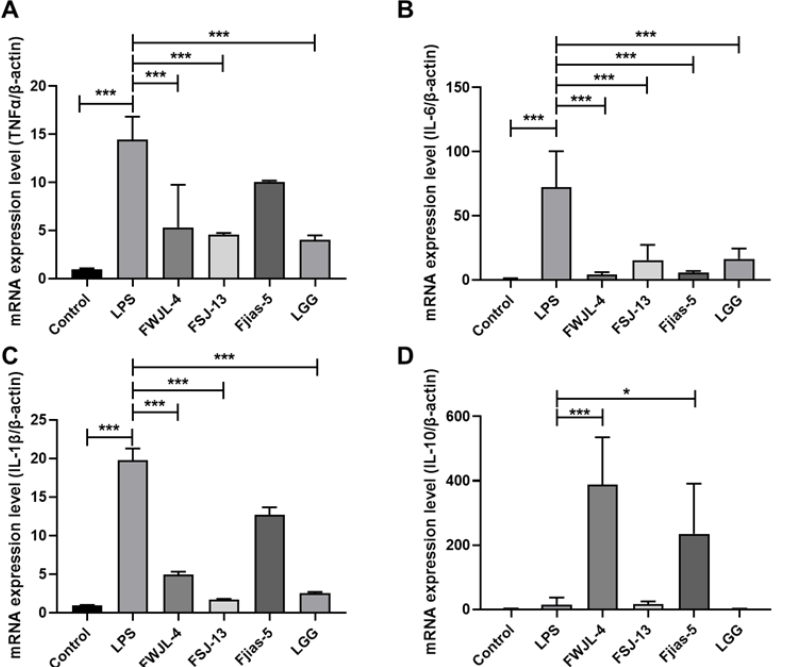
Figure 4. Selected probiotic LAB ( L. gasseri FWJL-4, L. plantarum Fjias-5 and L. rhamnosus FSJ-13) show anti-inflammatory effects in LPS-treated RAW 264.7 murine macrophages. ( A ) The mRNA expression level of TNF α . ( B ) The mRNA expression level of IL-6. ( C ) The mRNA expression level of IL-1 β . ( D ) The mRNA expression level of IL-10. All data were expressed as mean ± SD ( n = 3 independent experiments). Statistical significance was defined as * p < 0.05; *** p < 0.001. Reported statistical significance refers to comparisons with cell-treated with